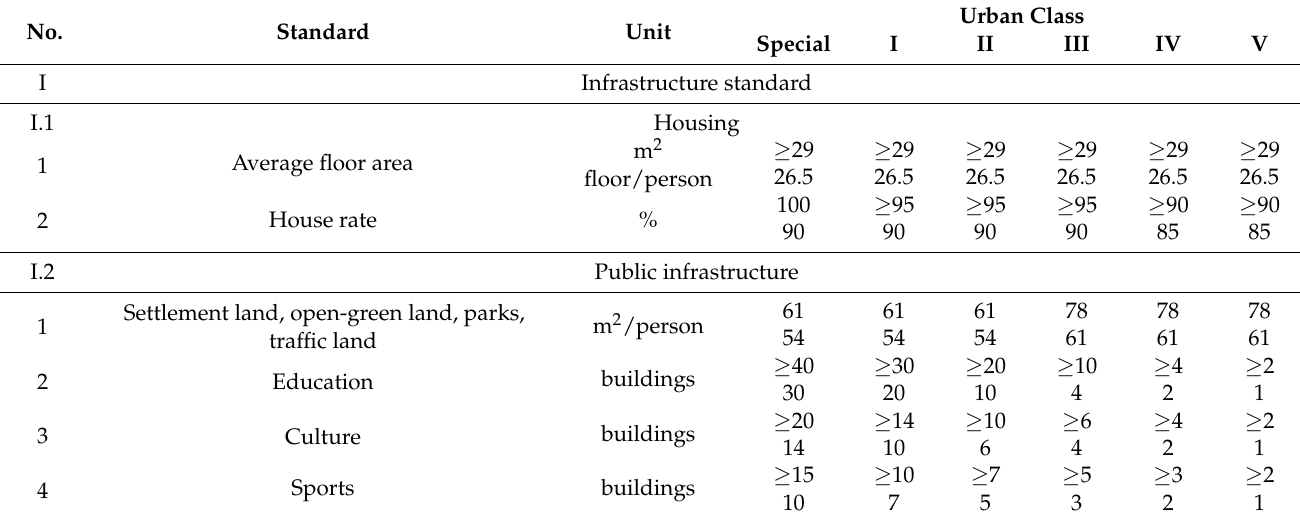
Table 2. Infrastructure development standard